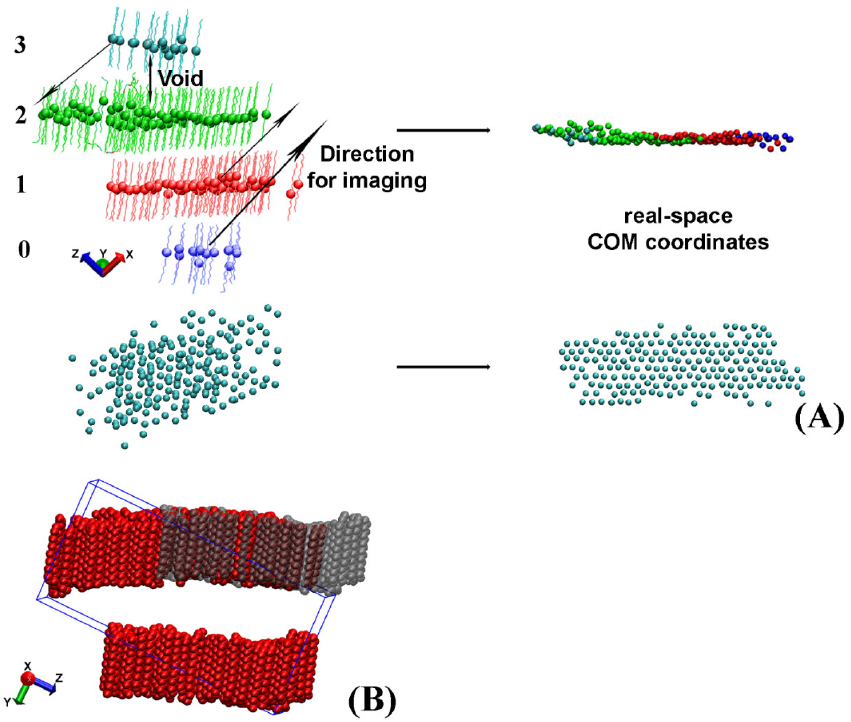
Figure 3. ( A ) Scheme of the procedure employed to reconstruct the real ‐ space coordinates of a crys ‐ tallite split across the periodic box taken from the HEX/Surf/water system. Each bead represents the center of mass (COM) of a molecule in the crystallite. The numbers on the left of the figure are indices of the slabs. In the given example, the direction of imaging is along x . ( B ) Illustration of the largest crystallite in bulk HEX split across the periodic box in the y direction. The red molecules are those saved in the periodic box and the grey ones are the ones resulting from the imaging along y to their real ‐ space coordinates.